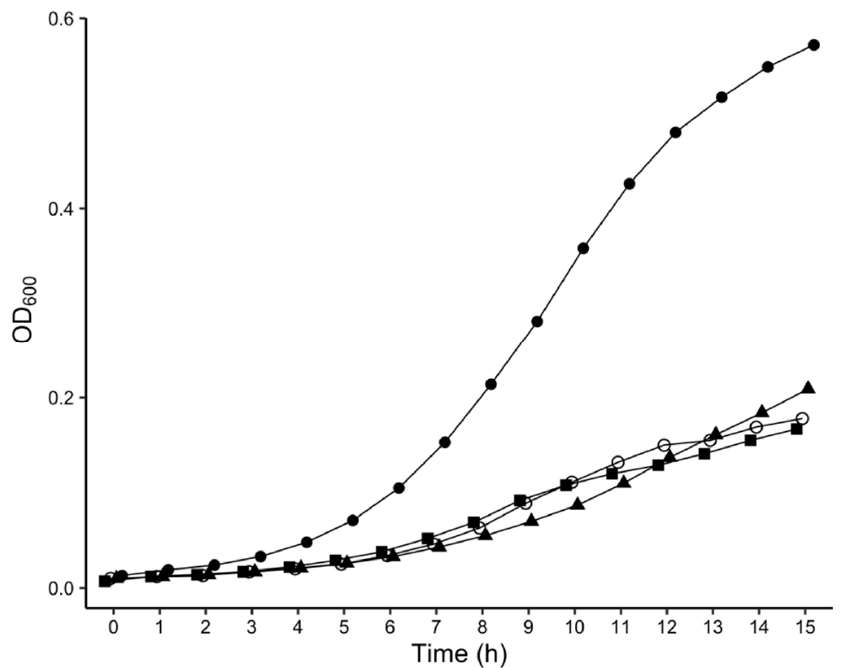
Figure 1. Growth curves of P. atrosepticum wild-type strain SCRI1043 (closed circle) and mutant strains PbaTn5-43 (closed square), PbaTn5-B58 (open circle), and PbaTn5-B76 (closed triangle) grown in M9 minimal media supplemented with 0.4% glycerol. The figure depicted only mutants where bacterial growth was significantly different from that of the wild-type P. atrosepticum SCRI1043. Bacterial growth was determined by measuring OD 600 against a medium blank. The values are expressed as the mean ( n = 6 from two independent experiments).